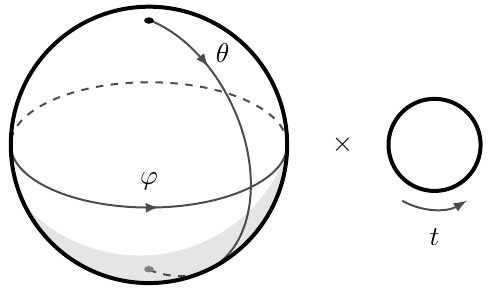
Figure 1 . The choice of coordinates on M